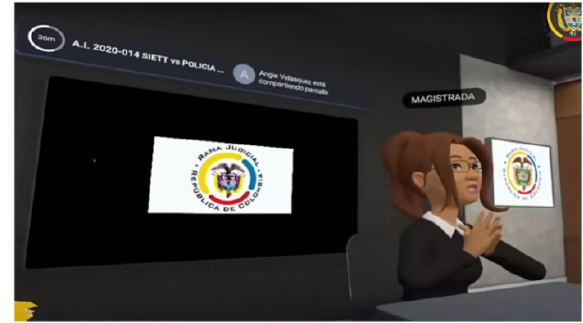
Figure 26: Colombian Court Hearing in the Metaverse